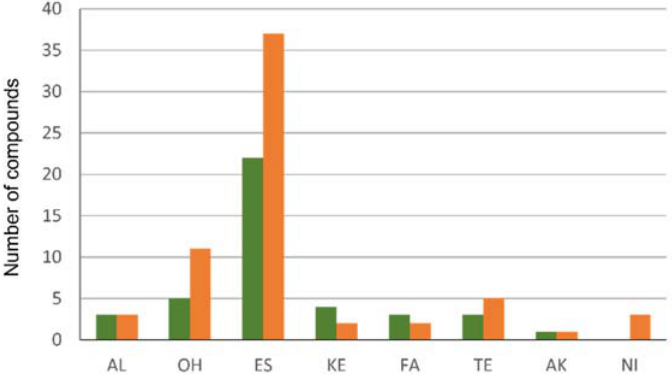
Figure 2. Chemical diversity of the volatile blends produced by sea buckthorn Hippophae rhamnoides berries at two ripening stages: green columns, unripe berries and orange columns, ripe berries.